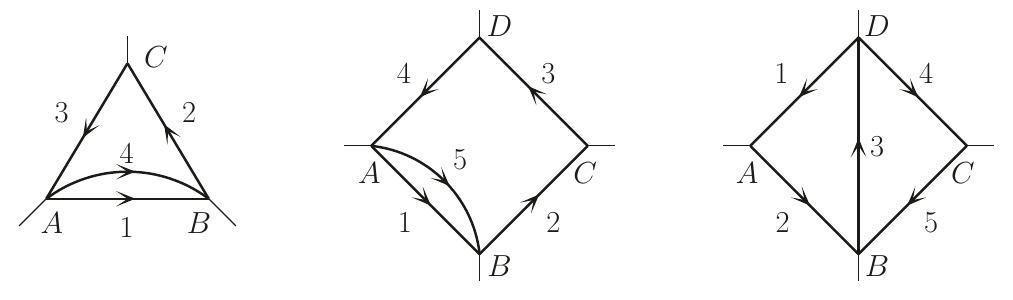
Figure 4 . Triangle and box diagrams with